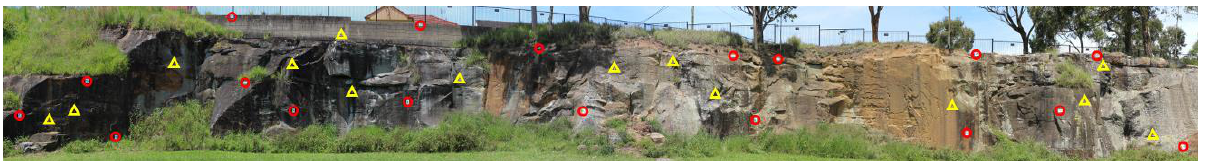
Figure 2. Panoramic view of the investigated rock face with GCPs: coded targets (red circle) and natural features (yellow